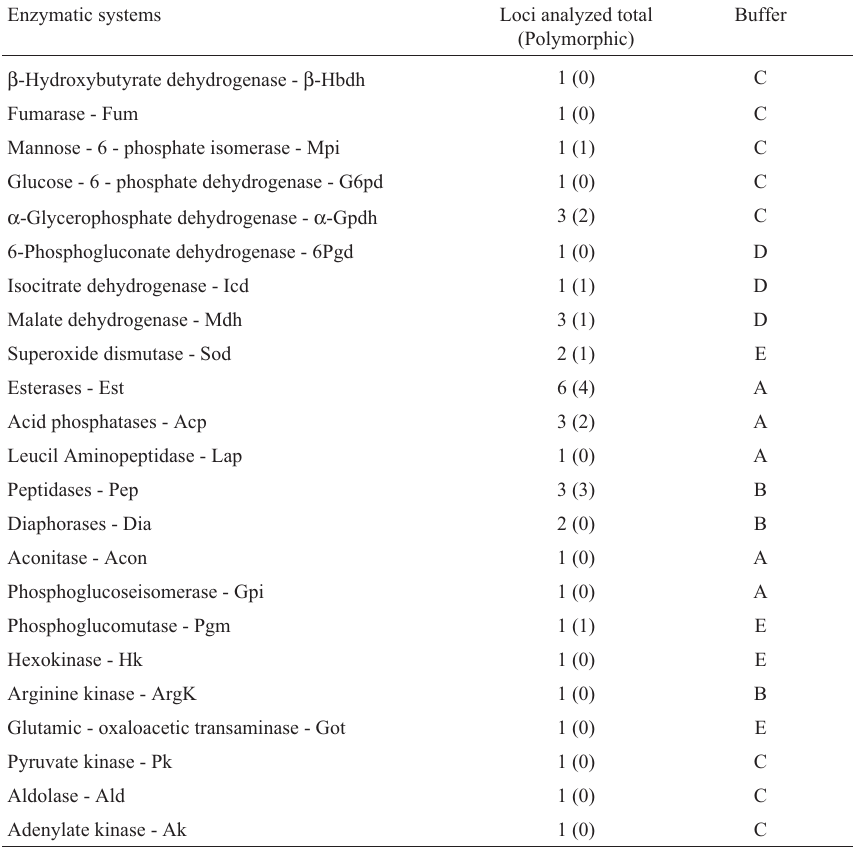
Table 1 - Enzyme systems, number of loci assayed (number of polymorphic loci in parentheses), and the respective buffers in which electrophoretic analyses were conducted in Digelasinus diversipes . Enzymatic